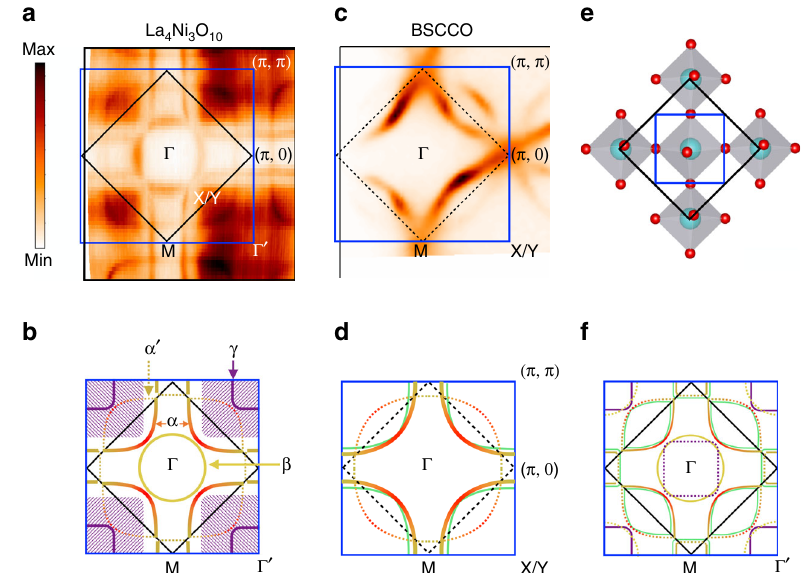
Fig. 1 Fermi surface map of La 4 Ni 3 O 10 . a , b The unsymmetrized Fermi surface of La 4 Ni 3 O 10 from ARPES measurement and schematic of the Fermi surface. c , d Fermi surface of optimally doped cuprate (Bi,Pb) 2 Sr 2 CaCu 2 O 8+ δ (BSCCO) and a schematic of its Fermi surface. The Fermi surface of La 4 Ni 3 O 10 can be divided into three parts. The hole pocket centered at Γ ′ is similar to the hole-doped cuprate Fermi surface ( solid red – yellow curve ) with the ( π , π ) back-folded band. This cuprate-like hole pocket corresponds to 17% of hole fi lling level. The other two parts are the extra electron ( yellow circle in b ) and hole ( purple curve and hatched area ) pocket around Γ and Γ ′ , respectively. e The real space unit cells of La 4 Ni 3 O 10. The black box corresponds to the two Ni unit cells where the blue box corresponds to the origin Ni-O plaquette. f Drawing of the Fermi surface in the repeated zone representation where pockets are back folded into the small Brillouin zone. The light green curves in d and f represent the extra band expected from multilayer band